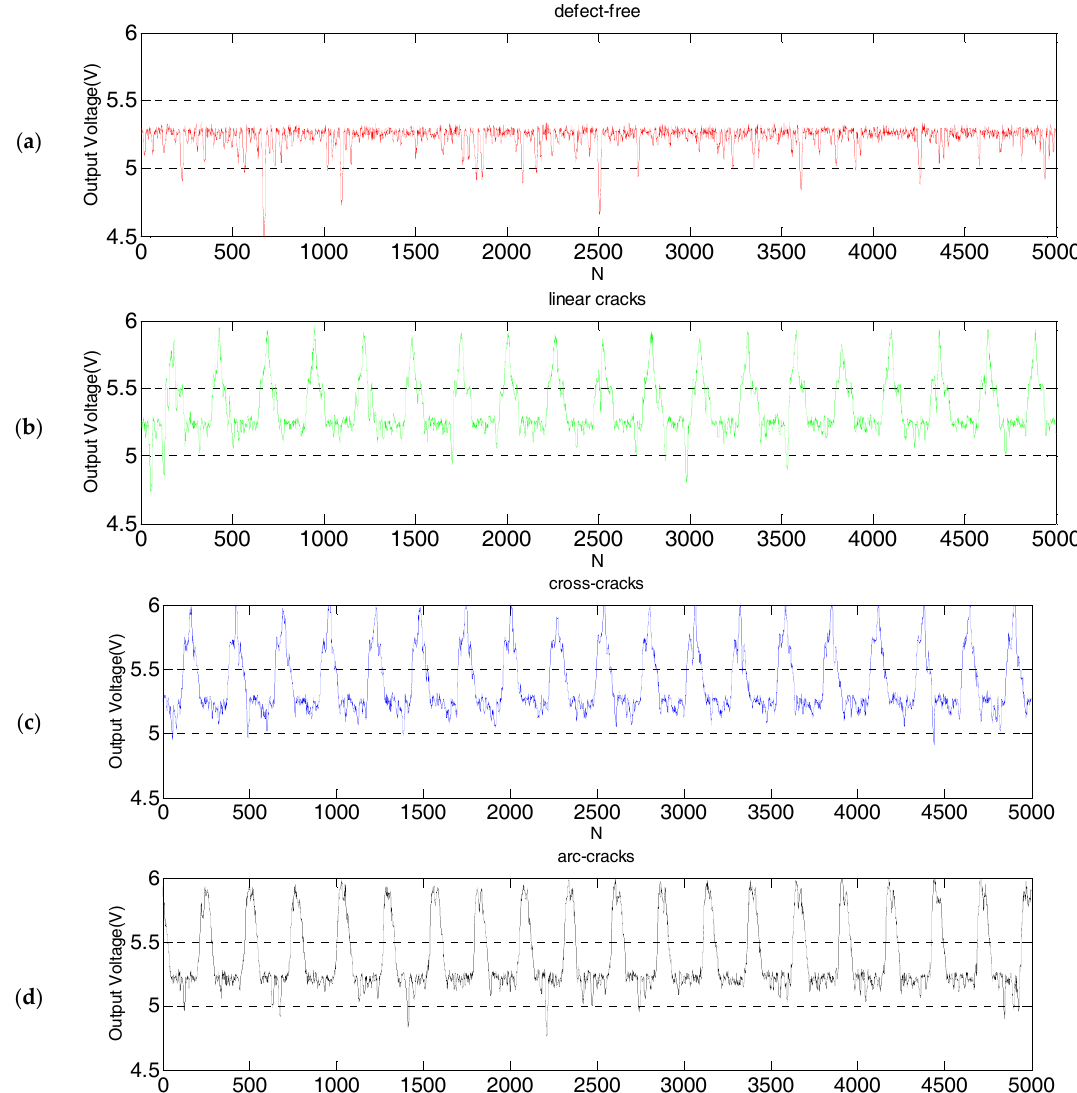
Figure 9. The inspection results of continuous sampling of 5000 points on a steel ball surface with a USB4711A (Advantech board, Advantech Co., Ltd., Taipei, Taiwan). ( a ) Inspection curve of steel balls without defect; and ( b – d ) inspection curves of steel balls with linear cracks, cross cracks, and arc cracks, respectively.